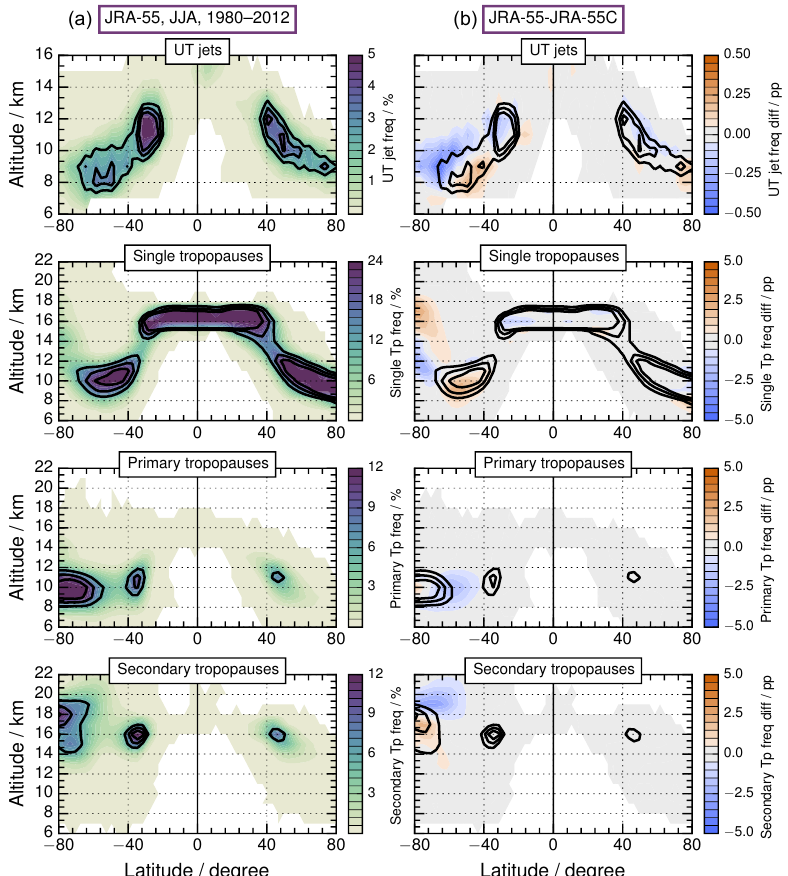
Figure 6. Seasonal latitude–altitude cross sections of frequency distributions for JJA in 1980 through 2012 of JRA-55 fields (a) and the difference between JRA-55 and JRA-55C fields (b) . Layout is as in Fig.